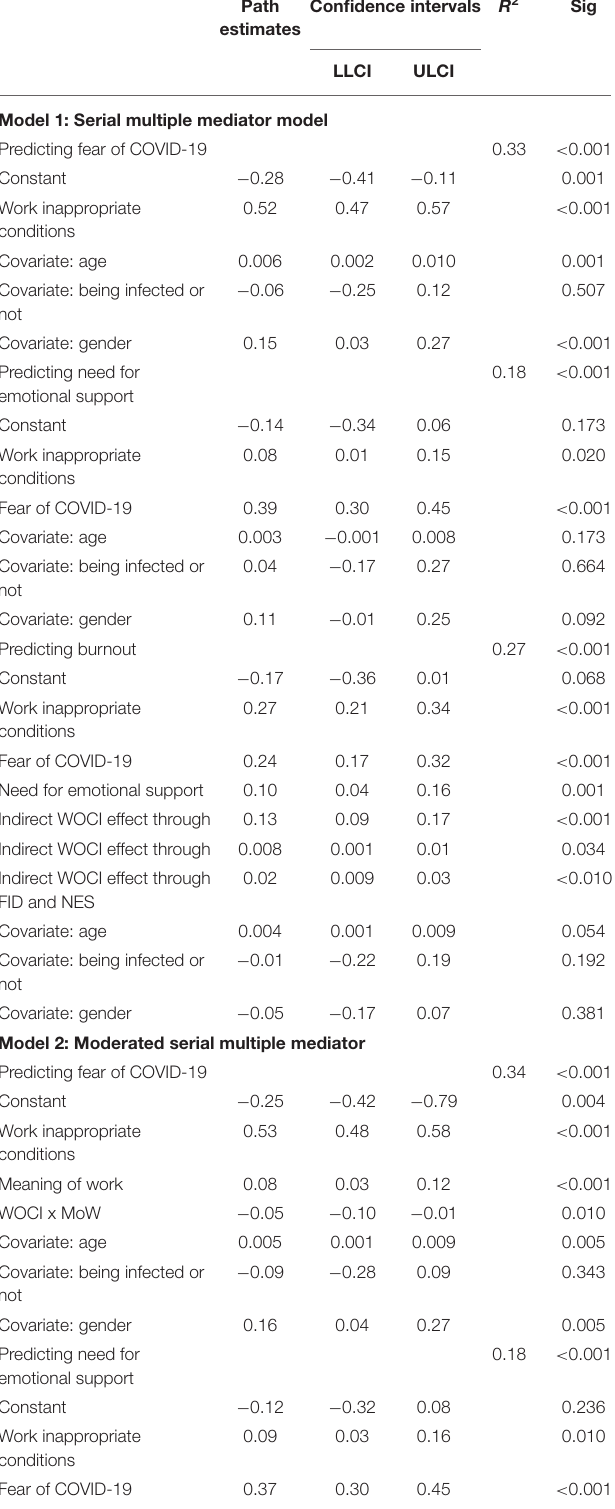
Path Confidence intervals R estimates